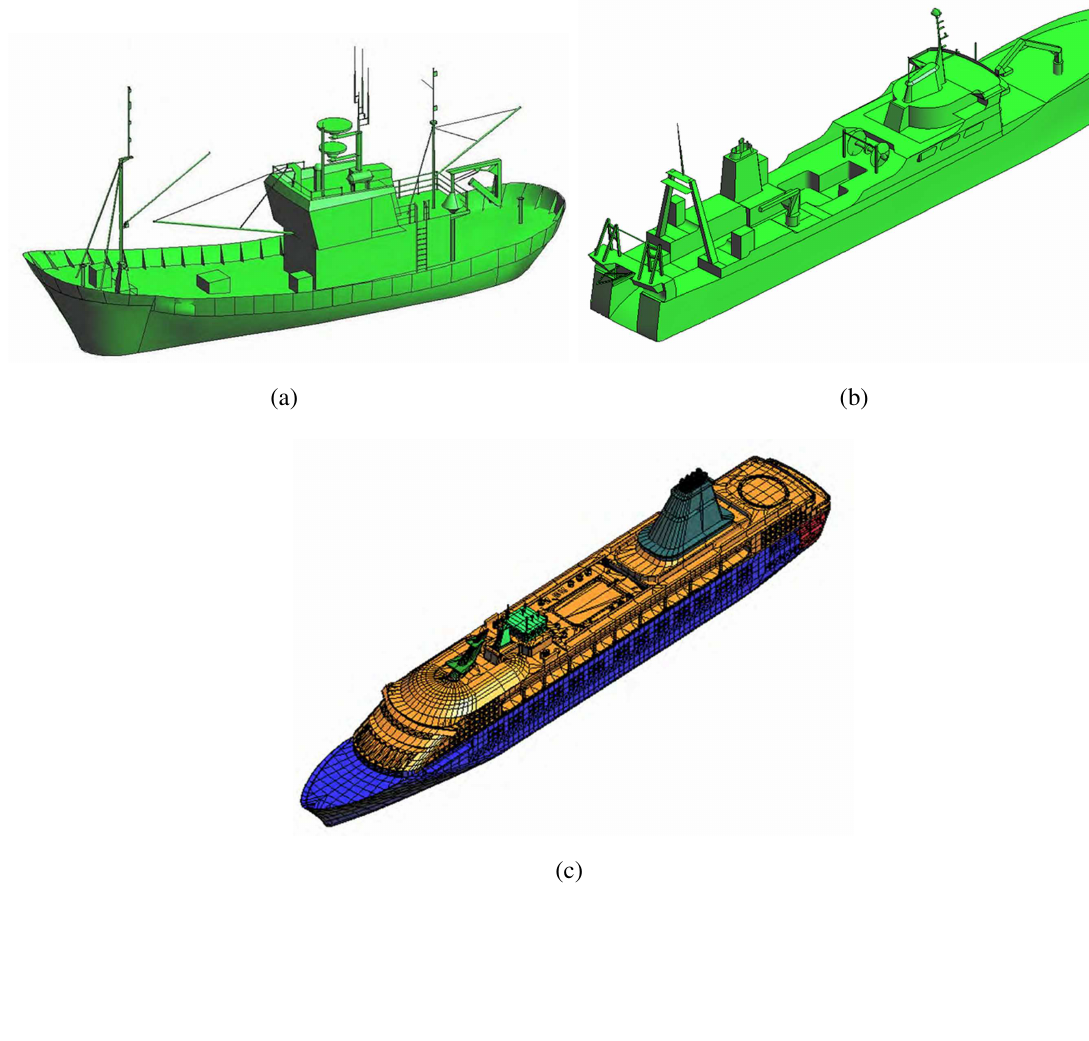
Figure 4. Snapshots of the SPA (a), ICE (b) and FER (c) models used in this work.